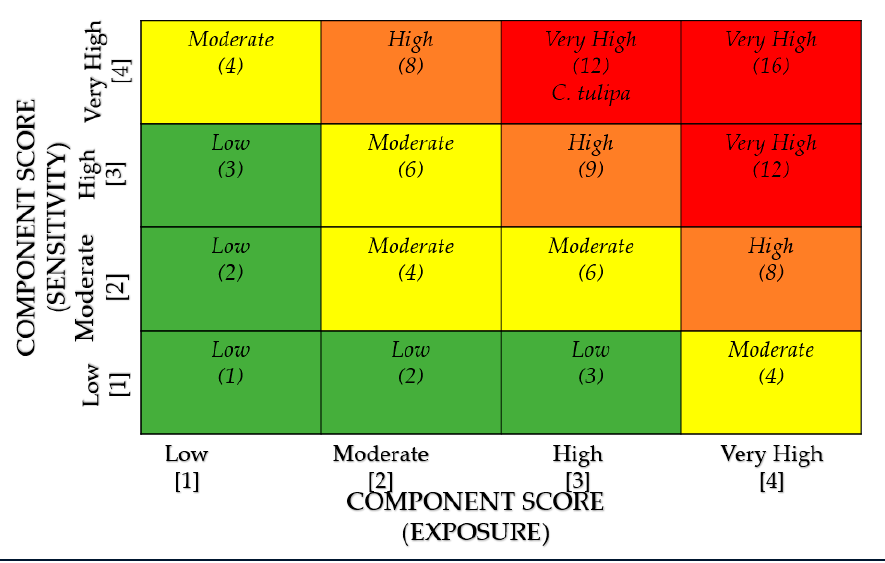
Figure 4. Vulnerability matrix showing the vulnerability region of C. tulipa estimated from sensitivity and exposure scores.